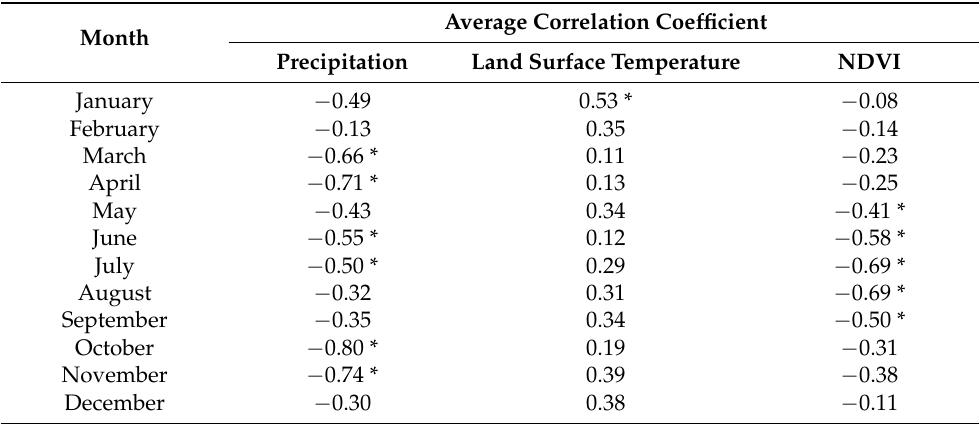
Table 9. Correlation analysis between monthly EDI and precipitation, land surface temperature, and NDVI. (* means passing the α = 0.05 significance